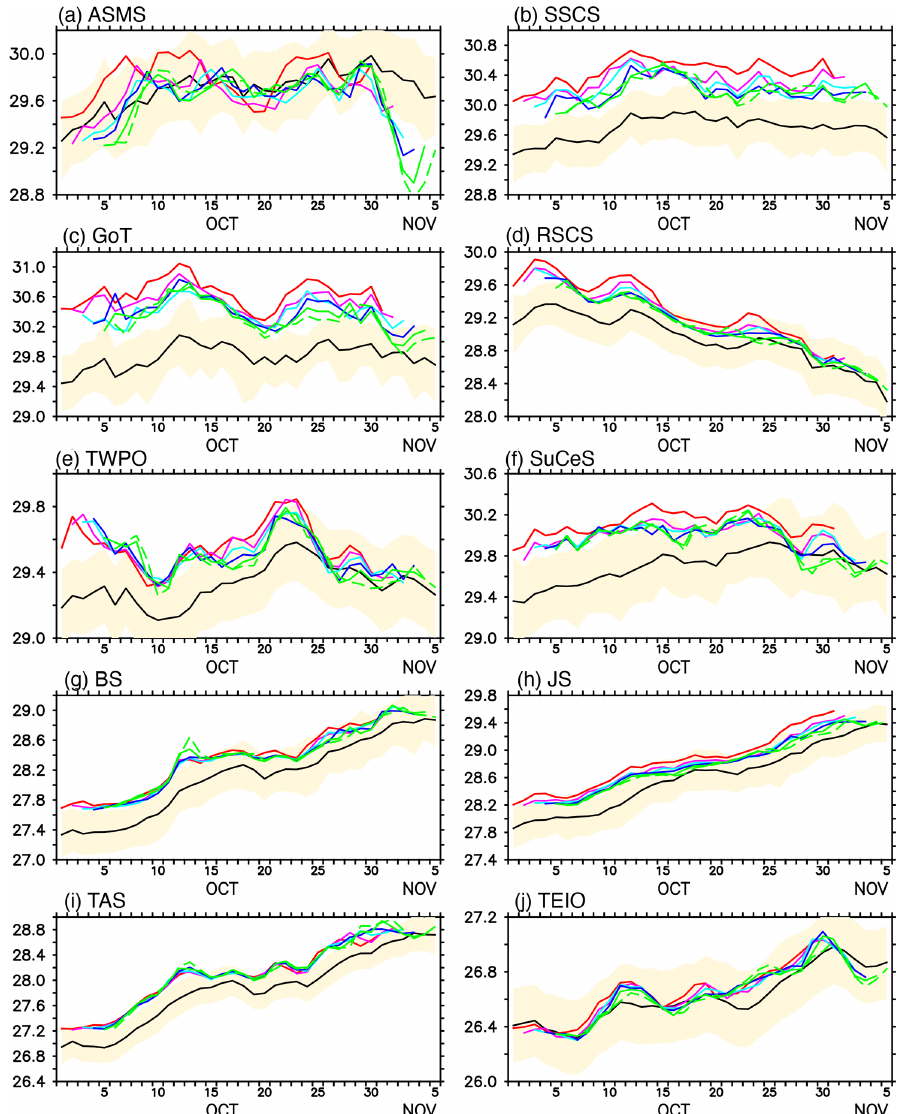
Figure 7. Time series of daily mean SST from model forecast and OSTIA averaged over the sub-regions: OSTIA (black line), fcst_day1 (red line), fcst_day2 (purple line), fcst_day3 (light blue line), fcst_day4 (blue line), fcst_day5 (green line), and fcst_day6 (dashed green line). Shading represents the estimated error standard deviation of analysed SST in OSTIA. (a) ASMS stands for Andaman Sea–Malacca Strait, (b) SSCS stands for southern SCS, (c) GoT stands for Gulf of Thailand, (d) RSCS represents the rest of the SCS, (e) TWPO stands for tropical western Pacific Ocean, (f) SuCeS stands for the Sulu–Celebes seas, (g) BS stands for the Banda Sea, (h) JS stands for the Java Sea, (i) TAS stands for the Timor–Arafura seas, (j) TEIO stands for tropical eastern Indian Ocean. The y axes are differ between the